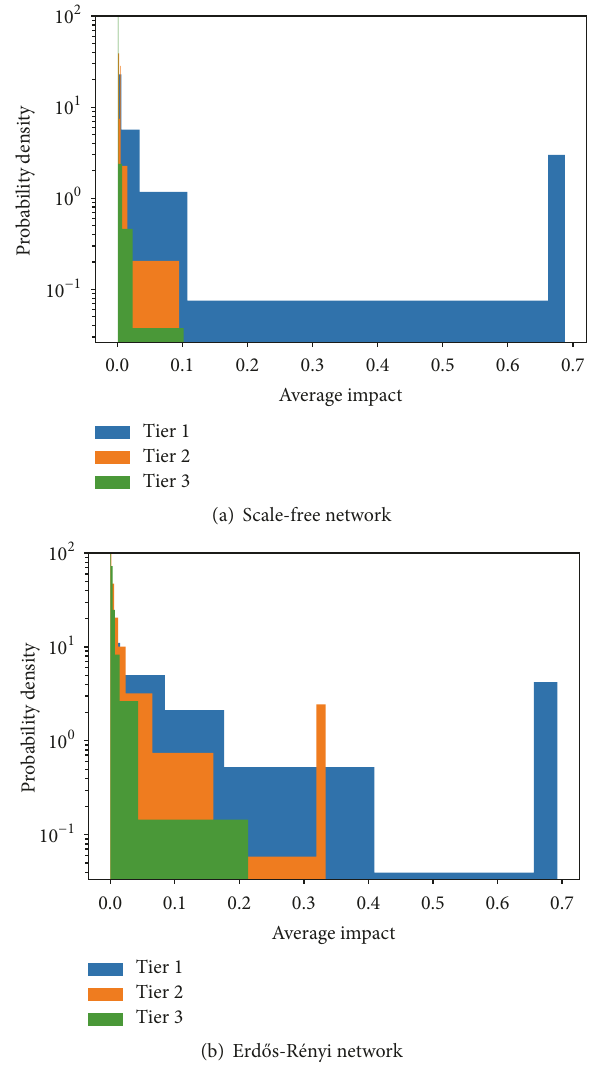
Figure 5: Histograms of the average impact I (𝑖) 𝑗 , across all possible node pairs (𝑖,𝑗) in which 𝑖 is a Tier 1/Tier 2/Tier 3 supplier of 𝑗 and the initial loss 𝑙 is beta-distributed ( 𝛼 = 5.0 , 𝛽 = 2.0 ). Medians: Tier 1: 0.0002 (scale-free), 0.0817 (E-R); Tier 2: 0.0 (scale-free), 0.0056 (E-R); Tier 3: 0.0 (scale-free), 0.0004